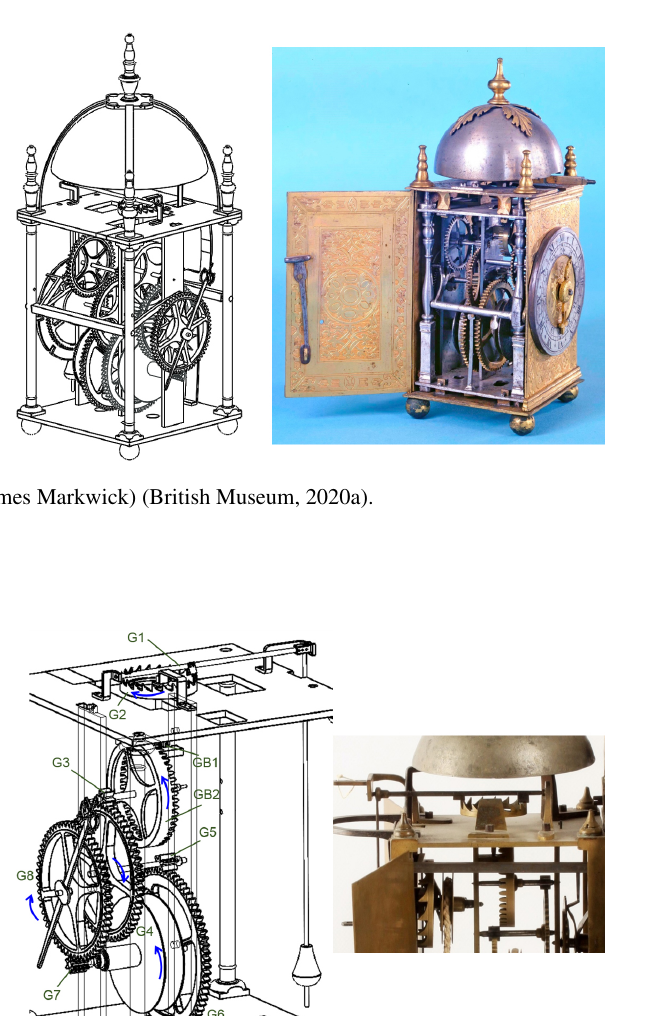
Mech. Sci., 13, 877–897, 2022